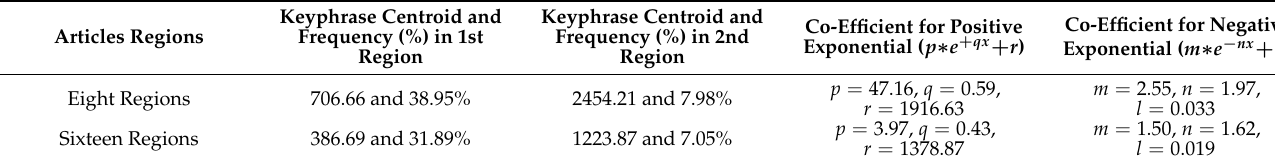
Table 3. Comparison of our proposed two approaches for KCFA